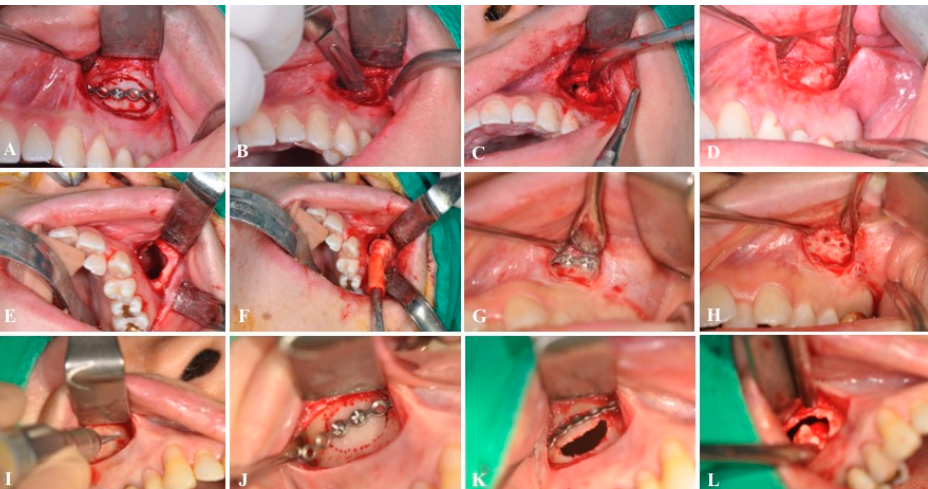
Figure 2. Surgical procedures of modified endoscopic-assisted sinus surgery. Case 1 : A pre-bent metal microplate was adapted to a prefabricated bony window ( A ). A small incision was made in the intact Schneiderian membrane to insert the endoscope ( B ). The tooth was removed with the force of the suction tip ( C ). Adequate bone healing was observed between the repositioned bony window and sinus wall after 1 year ( D ). Case 2 : The bony window can be enlarged to facilitate the removal of both the cystic lesion and the tooth ( E,F ). A minimal incision was made on the previous scar line to expose the microplate ( G ), and an intact sinus wall was confirmed through complete bone regeneration around the bony window after 1 year ( H ). Case 3 : The smallest round bur was used to make the bony window ( I ). Then the microplate was adapted ( J ) and removed with the bony window ( K ), and the tooth was successfully removed through the opening on the buccal sinus wall ( L ).